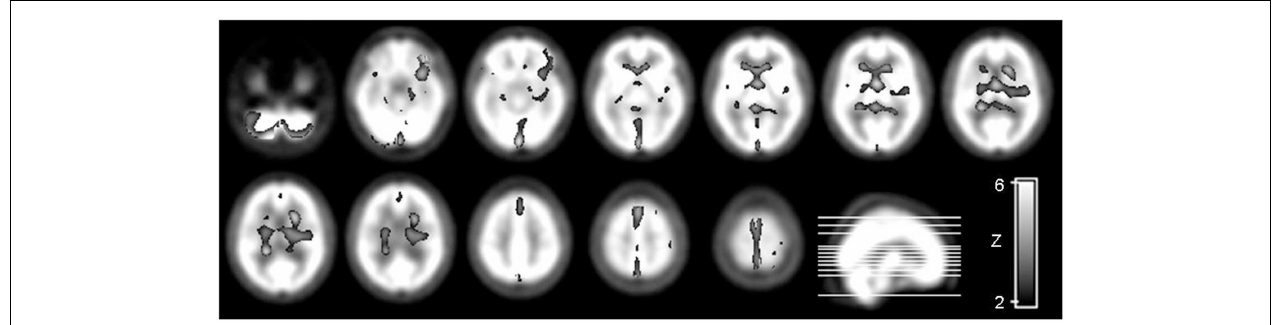
template” in radiological convention (i.e., the left side of the brain is displayed in the right side of the image).The statistical threshold was set at p < 0.05 looking for clusters with at least 32 contiguous voxels, corrected by multiple comparisons using